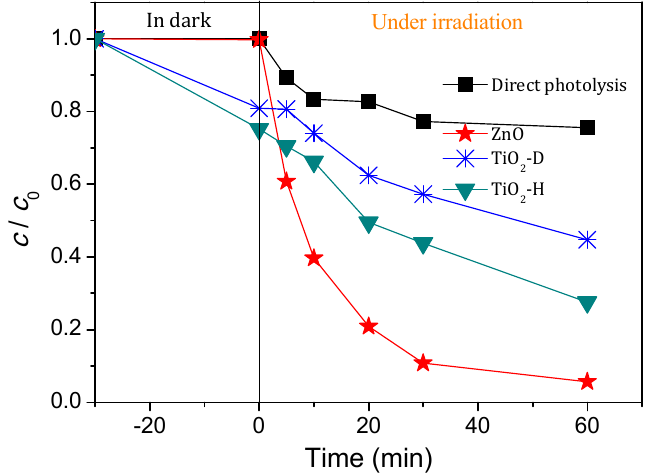
Figure 2. Kinetics of direct photolysis and photocatalytic degradation of AMI (0.0300 mmol/L) in the presence of different nanopowders (1.0 mg/mL) using solar radiation.